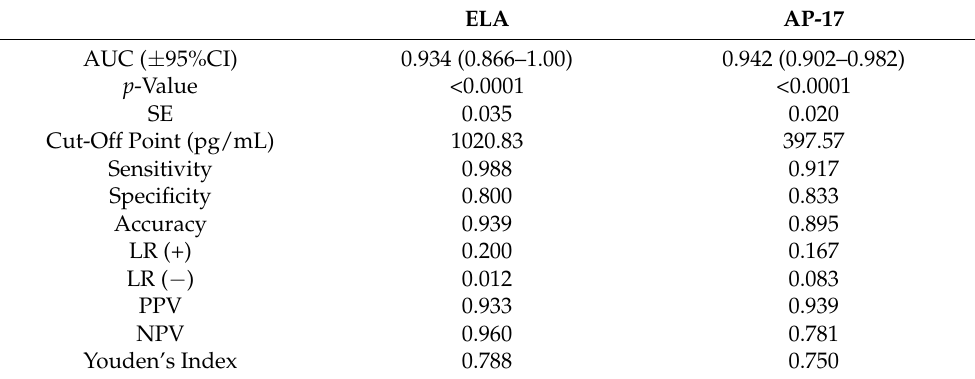
Table 5. Diagnostic potential of ELA and AP-17 as indicators of myocardial infarction.